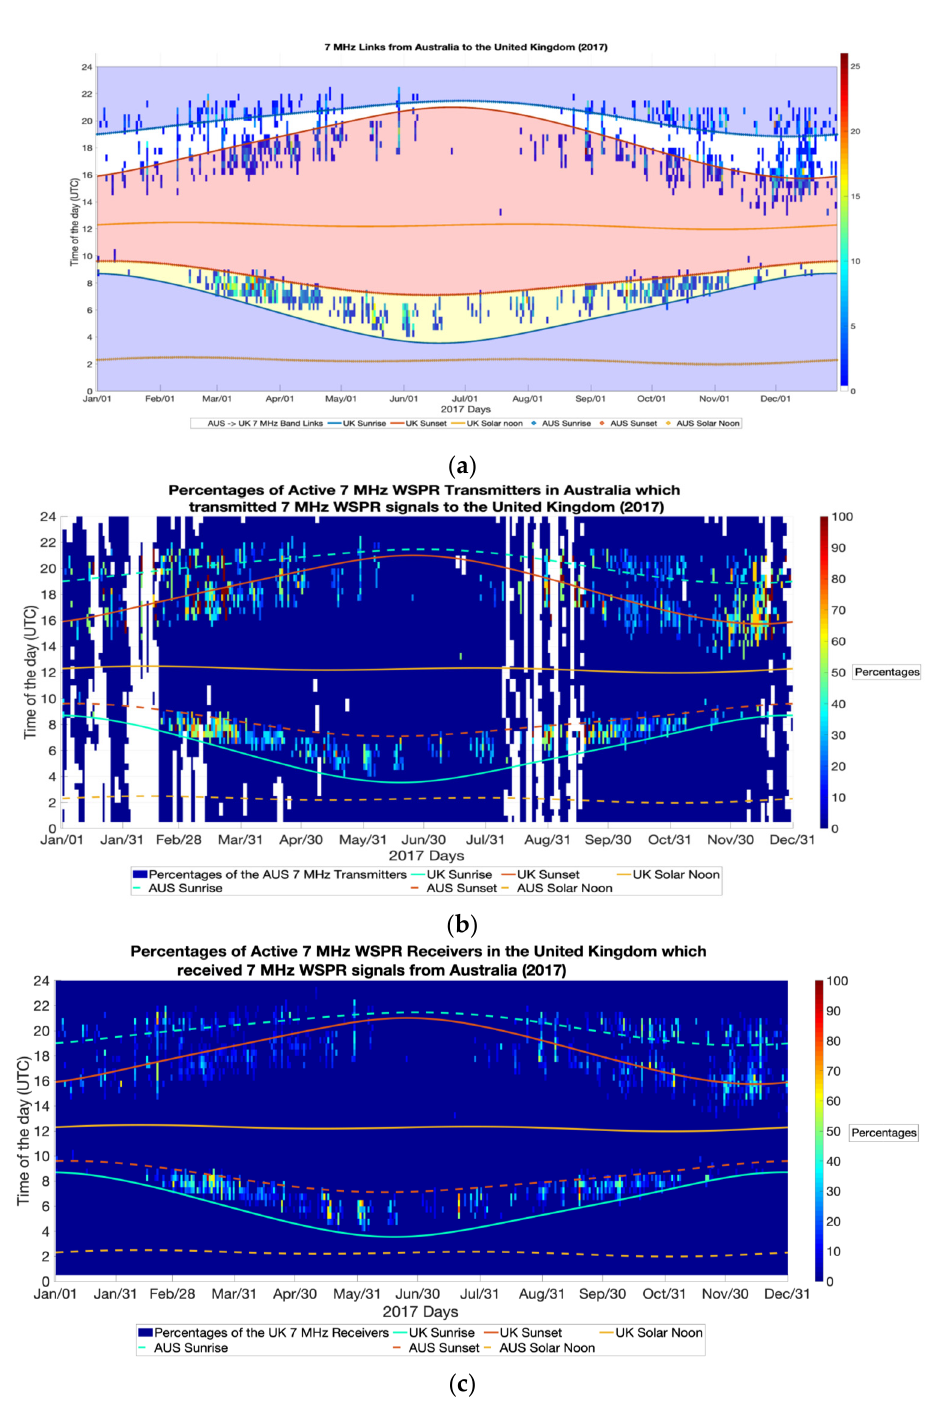
Figure 13. ( a ) The 7 MHz radio links made from Eastern Australia to the UK in 2017. The blue shaded area is the Australian daytime hours. The red area is the UK daytime hours. The yellow shaded area is the common daytime hours, and the white shaded area is the common night hours. The colours indicate the number of links available in each half-hour interval. ( b ) Percentages of active Eastern Australia WSPR transmitters which have transmitted a link to the UK in 2017. Only transmitters with a proven capability to cover the distance from Eastern Australia to the UK are shown. The colours indicate the number of receivers available in each half-hour interval. ( c ) Percentages of active UK WSPR receivers which have receivers a link from Eastern Australia in 2017. Only receivers with a proven capability to cover the distance from Eastern Australia to the UK are shown. The colours indicate the number of receivers available in each half-hour interval.